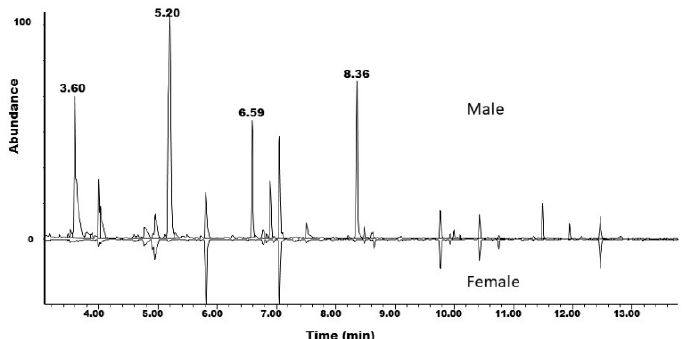
Figure 3. Total ion chromatograms of extracts of volatiles from male (top) and female (bottom, inverted) Plagionotus detritus . Compound identifications: retention time 3.60 min, 2,3-hexanedione; 5.20 min, ( R )-3-hydroxyhexan-2-one; 6.59 min, 2,3-octanedione; 8.36 min, ( S )-2-hydroxyoctan-3-one.